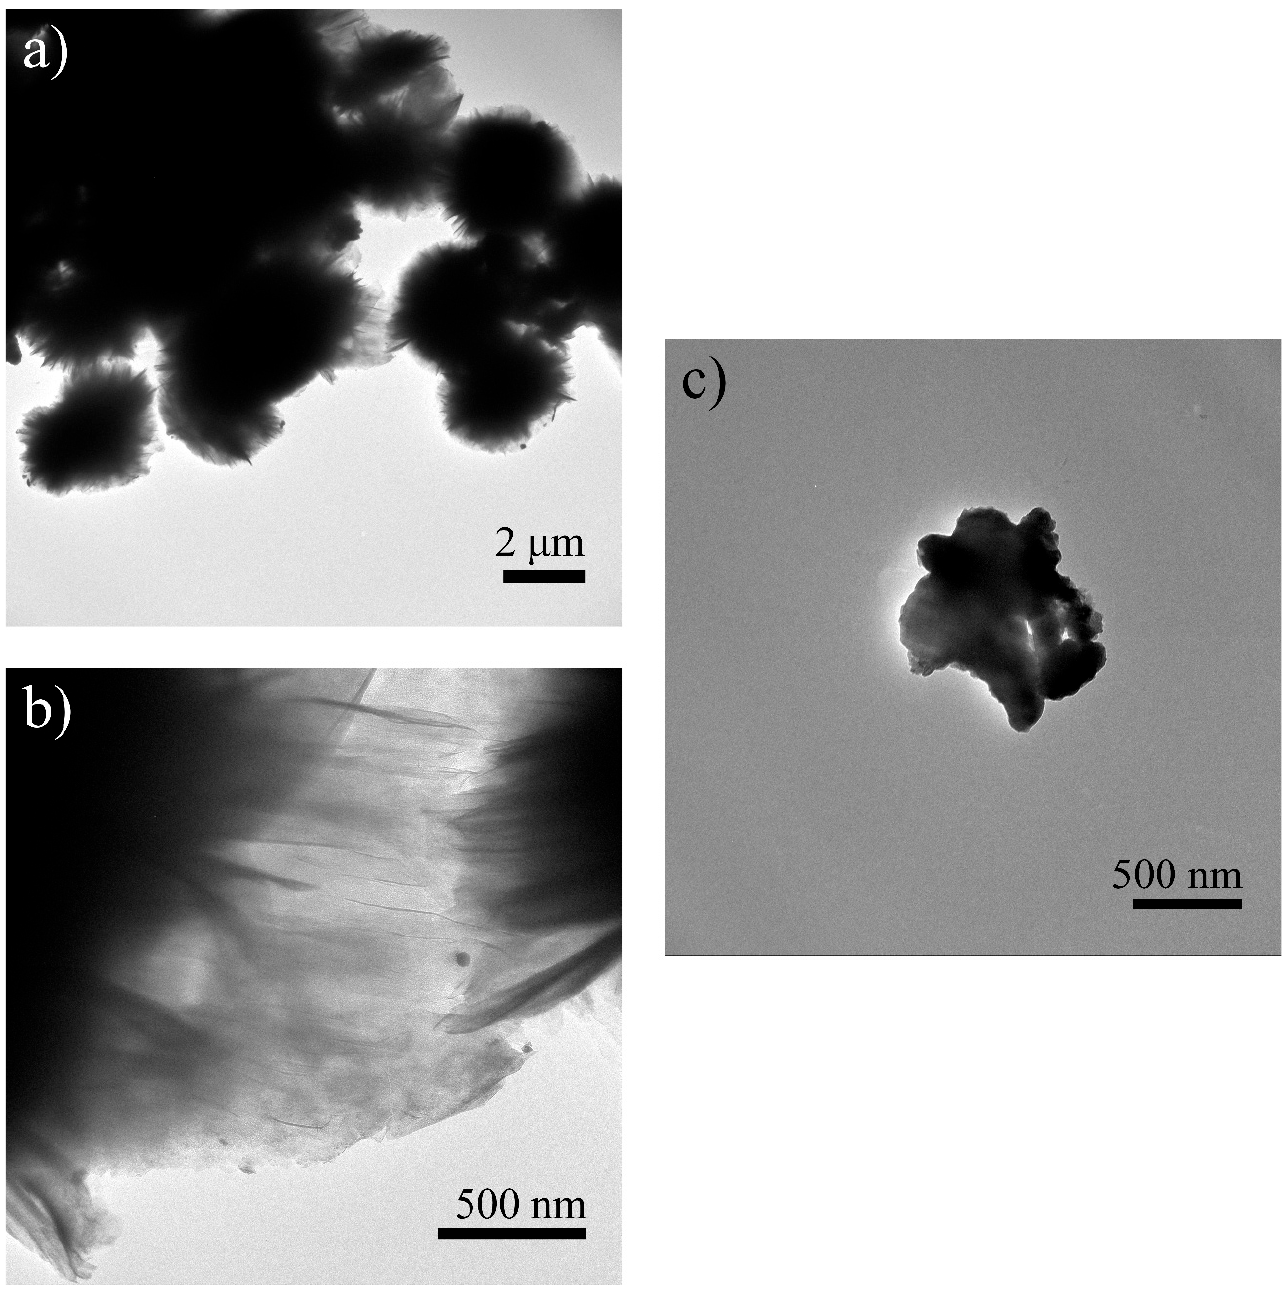
Figure 7. TEM images of P-180 synthetized products: ( a ) and ( b ) flower-like morphology, and ( c ) nanoparticles agglomerate.